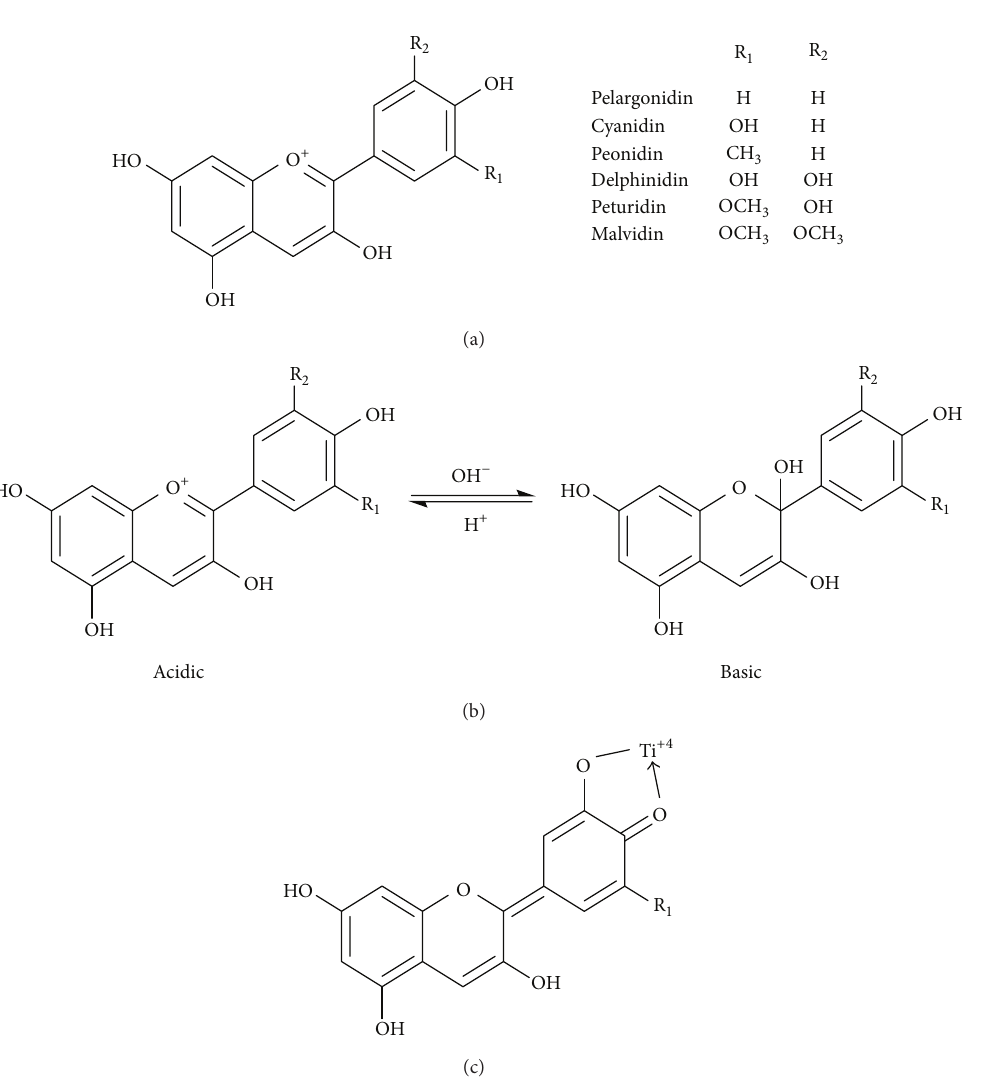
Figure 5: (a) Chemical structures of anthocyanins. (b) Structure in acidic and basic media. (c) Chelation mechanism with TiO 2 [79].